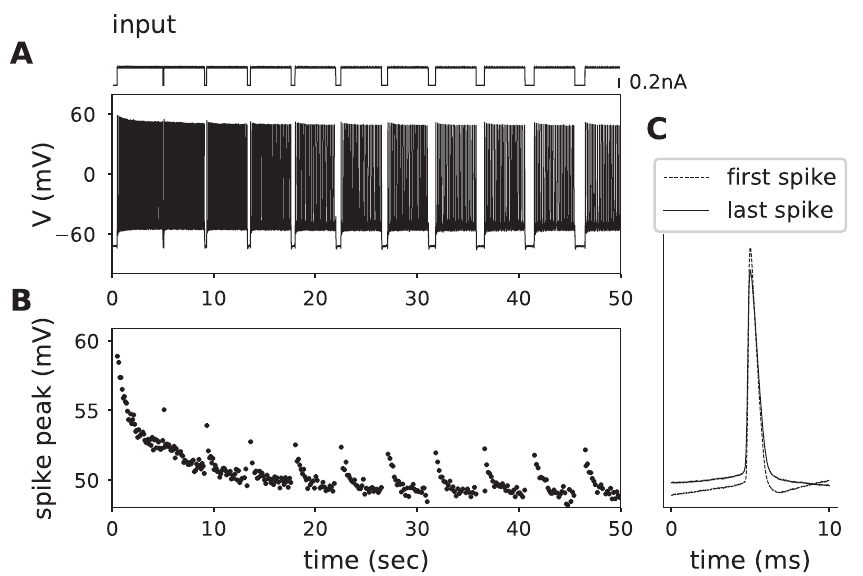
Fig 5. Activity-dependent decrement in action potential amplitudes. A . Membrane potential of a rodent cortical neuron (lower trace), subjected to prolonged DC current punctuated by brief hyperpolarizing pulses with different durations (top trace). B . Plot of peak voltage for each action potential shown in A. Note that action potential peaks fail to recover after even 1 second long breaks in current stimulation. C . Overlay of the first and last action potentials shown in A (aligned at 5